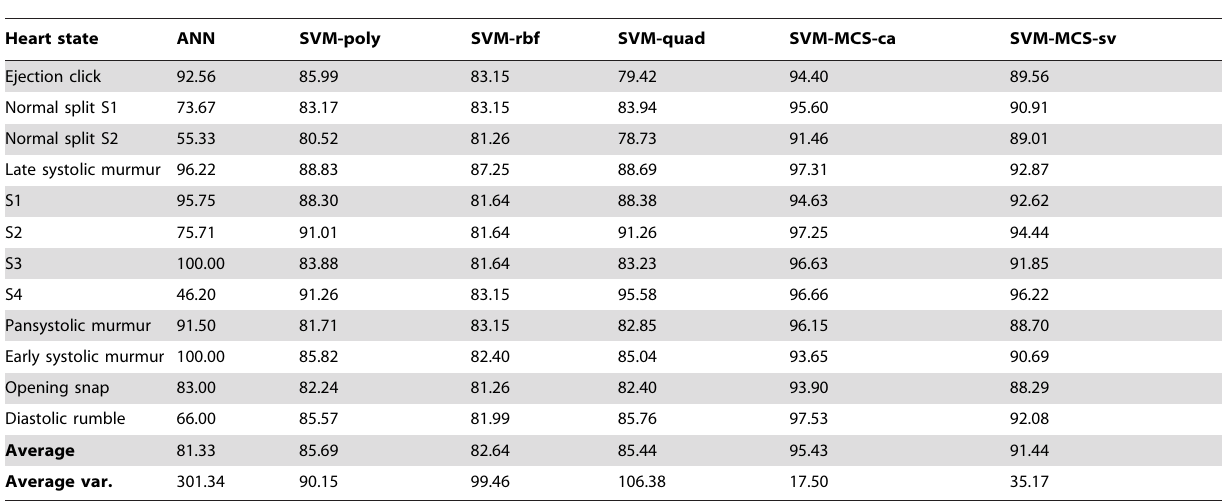
Table 1. Percentage of correctly classified signals for different heart sounds.